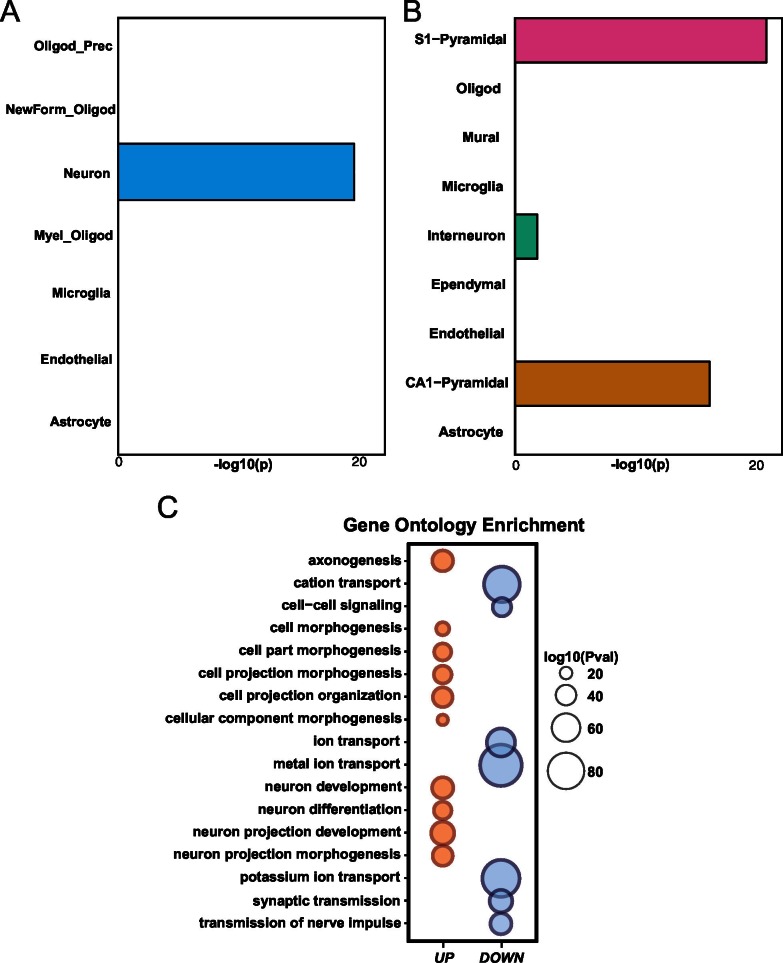
Differential gene expression in Mef2c cKO cortical tissue.(A) Mef2c cKO DEGs were significantly enriched for neuron-specific genes. (B) Mef2c cKO DEGs were significantly enriched for S1-Pyramidal and CA1-Pyramidal neurons. Gene ontology enrichment for Mef2c cKO DEGs. In red, the up-regulated genes; in blue, the down-regulated genes. Circle size is correlated with the adjusted p-value. Gene ontology categories are alphabetically listed on the y-axis. Differentially expressed genes showed enrichment for categories involved in neuronal development and synaptic transmission.